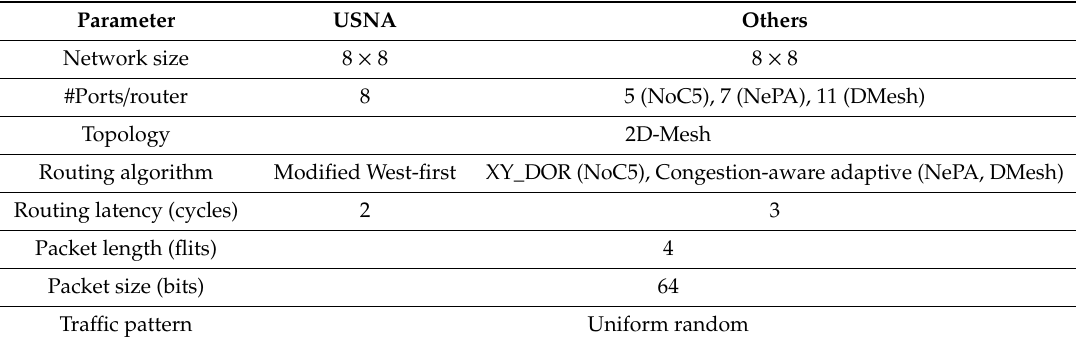
Table 2. Network simulation Table 3. Network simulation parameters.